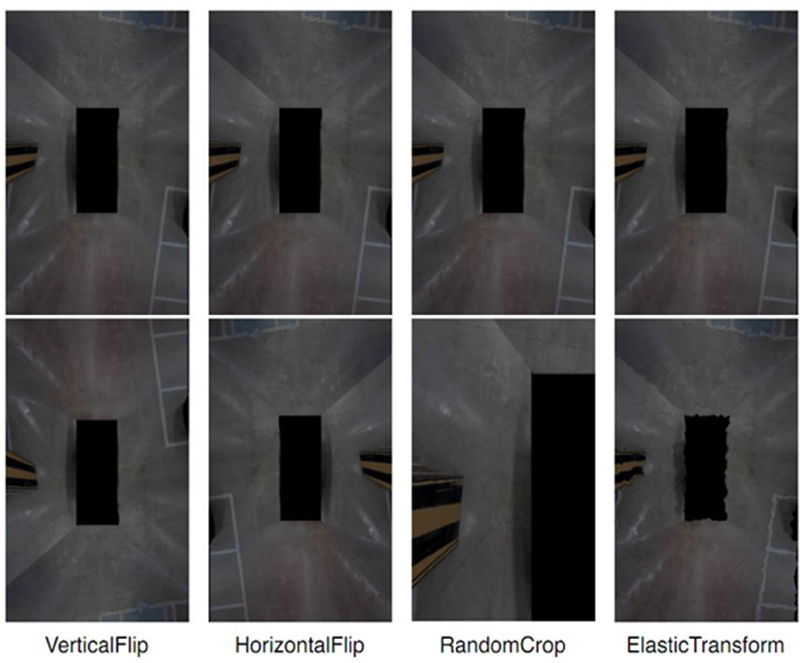
Figure 4. Data augmentation methods for training.